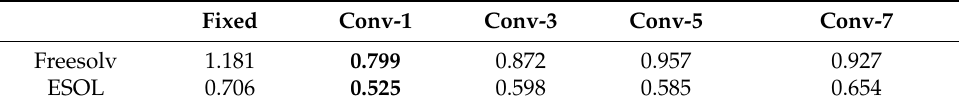
Table 8. Averages of MAE using fixed and learned edge